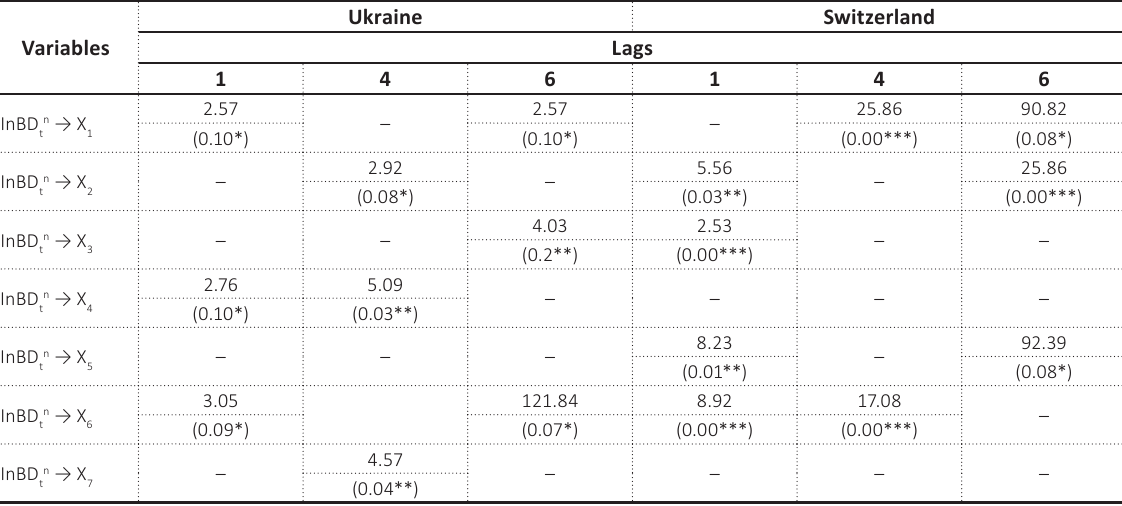
Table 5. Mutual causality of parameters of economic growth and the banking sector development of Ukraine and Switzerland,